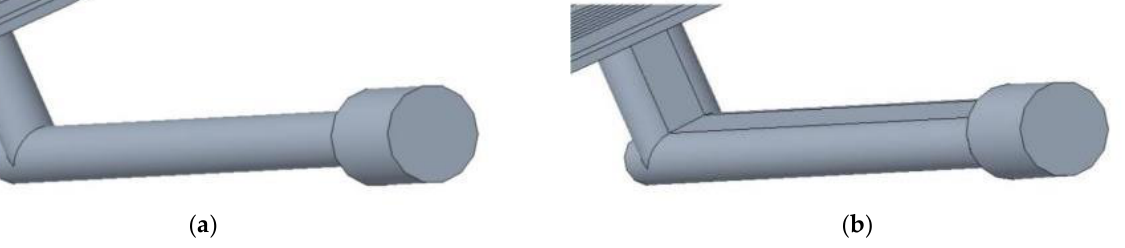
Figure 9. Change of air inlet pipe cross section. ( a ) Inlet pipe circular section. ( b ) Inlet pipe oval section.